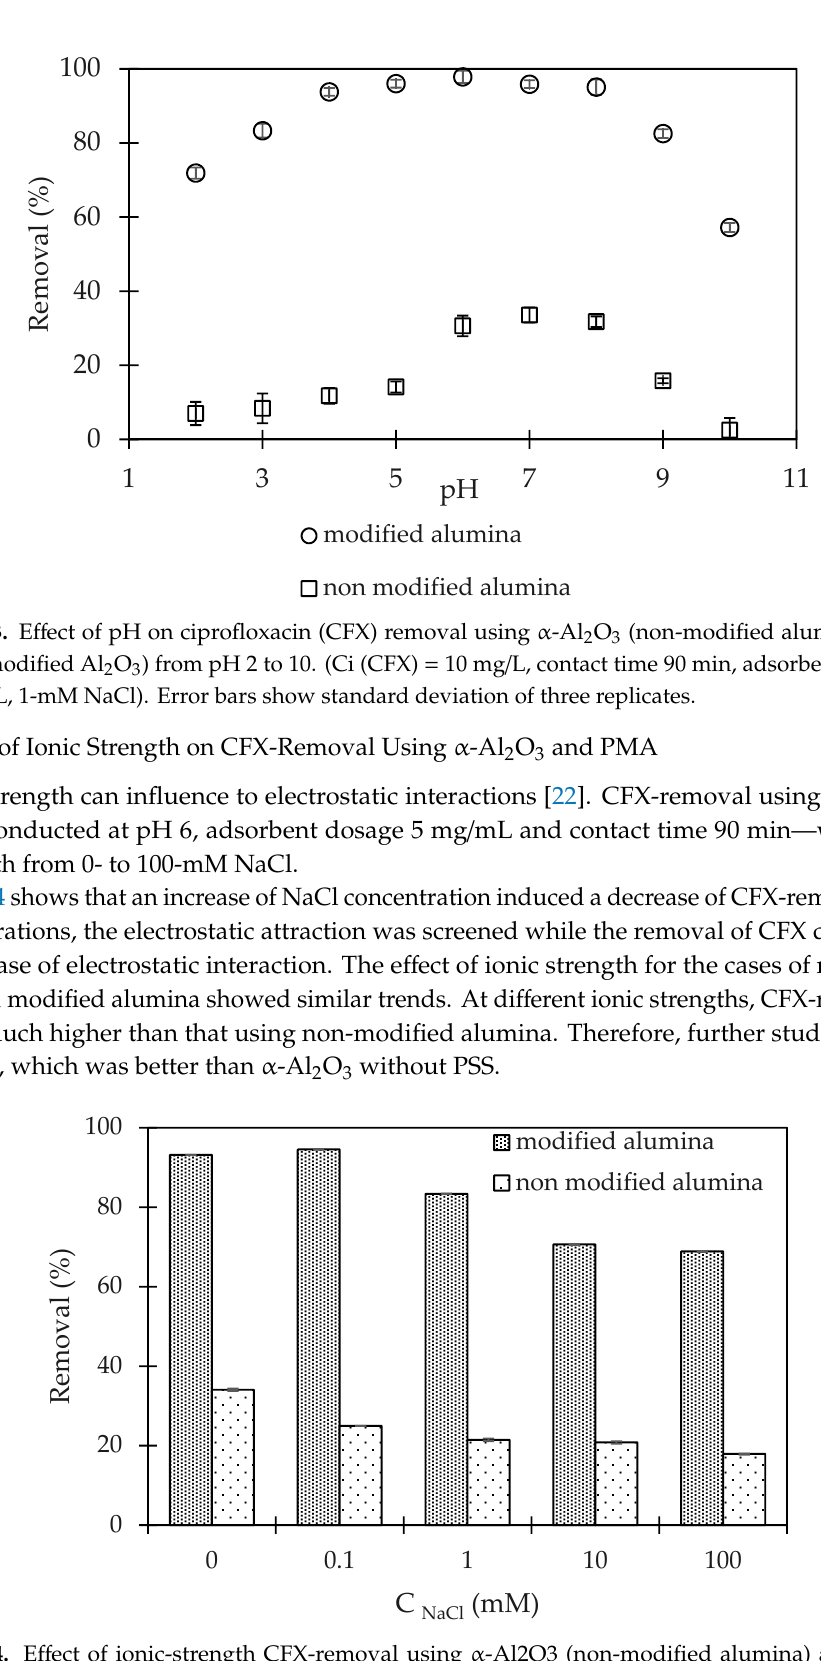
Figure 4. Effect of ionic-strength CFX-removal using α -Al2O3 (non-modified alumina) and PMA (modified alumina). (Ci (CFX) = 10 mg/L, contact time 90 min, adsorbent dosage 5 mg/mL, pH 6). Error bars show standard deviation of three replicates.